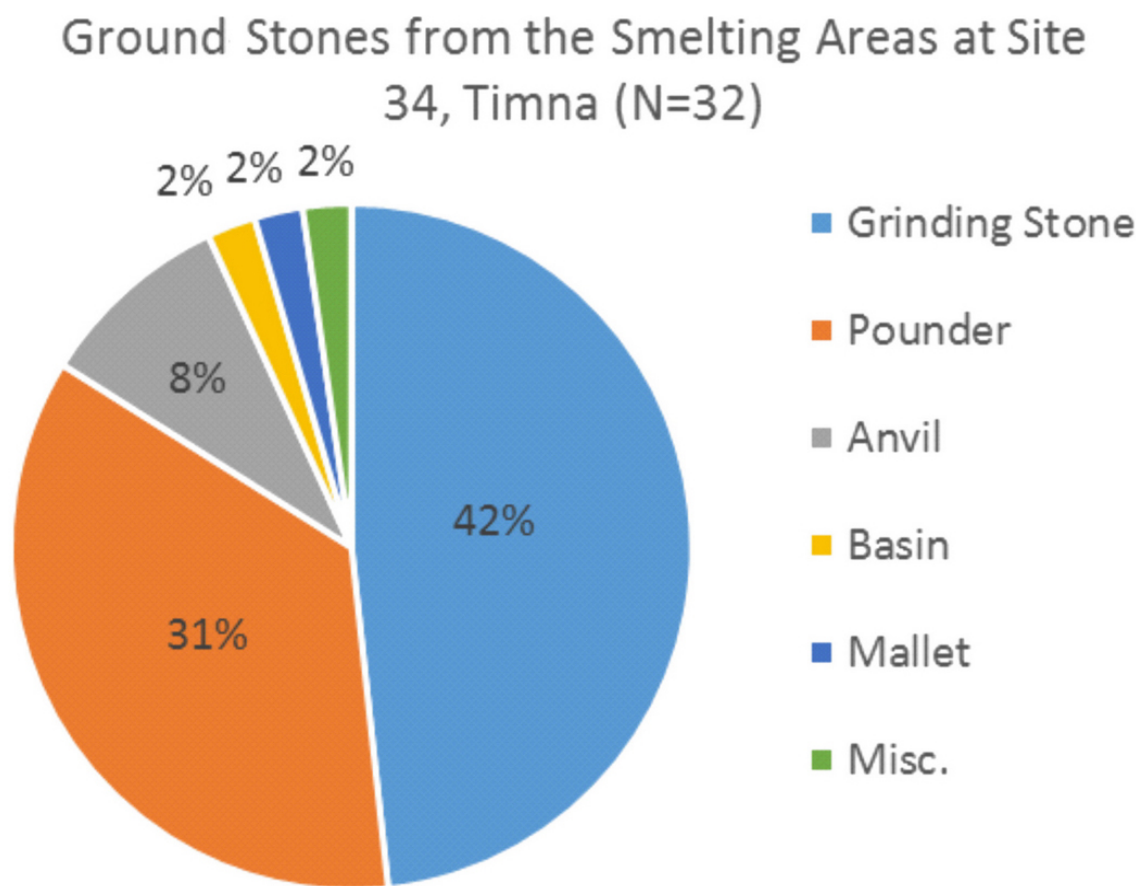
Figure 15. Distribution of ground stone tool types at Site 34 smelting